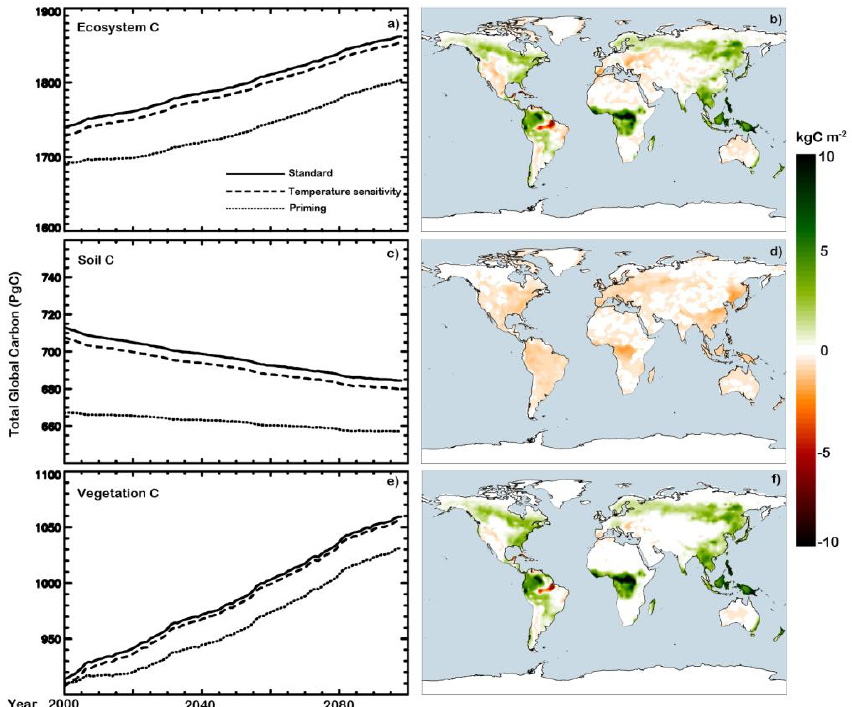
Figure 6. Predicted total global organic carbon in the entire ecosystem (a) , soil (c) and vegetation (e) starting from equilibrium year 2000 underpredicted climate change with ES (“standard”), ET (“temperature sensitivity”) and EP (“priming”). The spatial maps show the changes between the average of the last 25years of the equilibrium run and the average of the last 25years of the future run (i.e. the period 2075–2099) for total ecosystem C (b) , soil C (d) , and vegetation C (f) using the standard